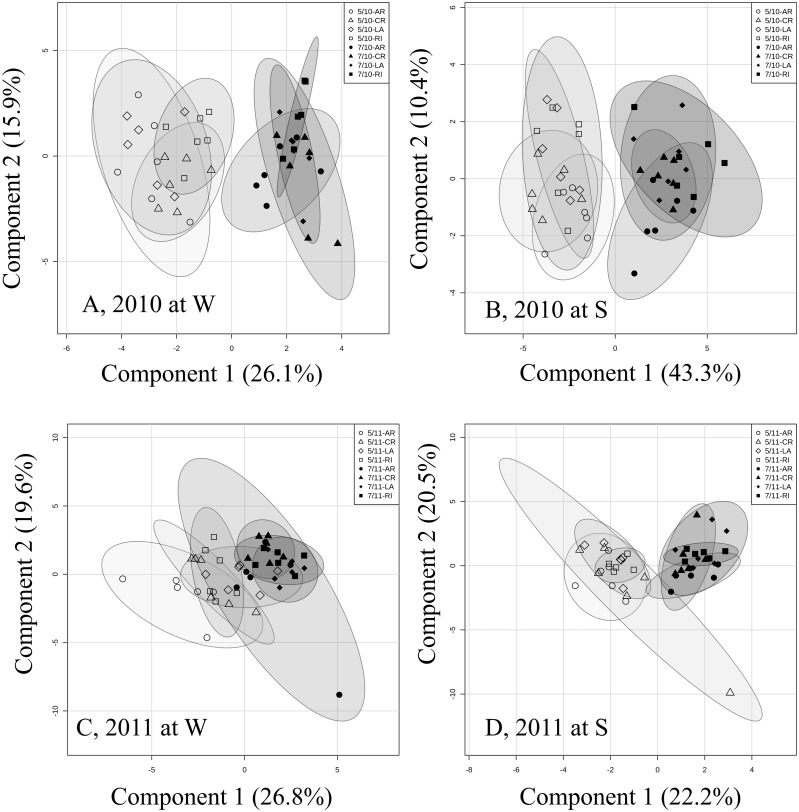
Clustering of N pools and free amino acids in needles computed separately per year.Sampling was done in May and July 2010 (5/10 and 7/10) and 2011 (5/11 and 7/11). Figures represent score plots of a partial least squares–discriminant analysis computed per year and site. A) and C) show plots for Wiesloch (W), B) and D) for Schluchsee (S). Douglas-fir provenances (AR, Salmon Arm; CR, Conrad Creek; LA, Cameron Lake; and RI, Santiam River) are represented by different symbols, open and solid symbols indicate individual trees. Semi-transparent shadings indicate 95% confidence regions.